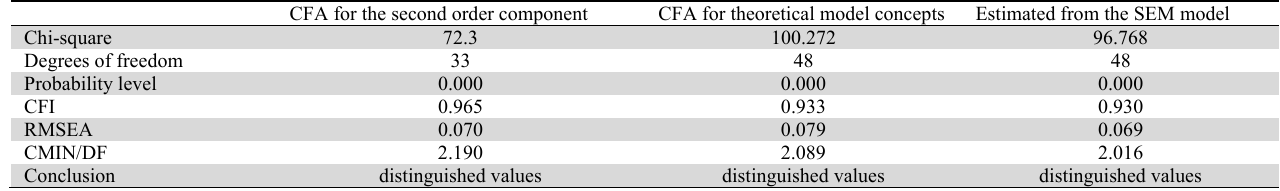
Source: Authors' calculations from survey